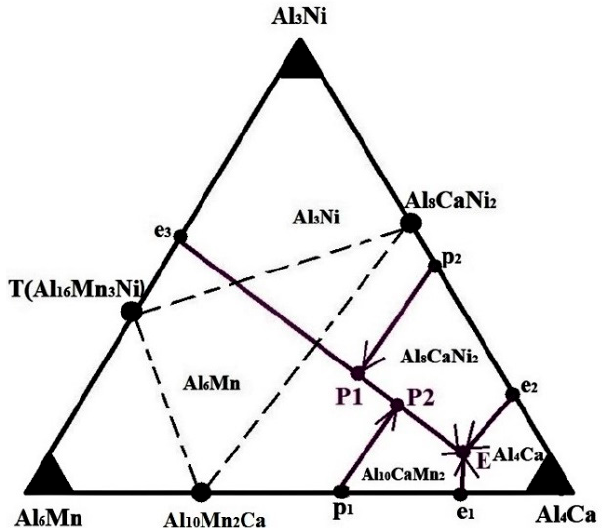
Figure 11. Hypothetical distribution of the solid phase fields in the Al-Ca-Mn-Ni system.